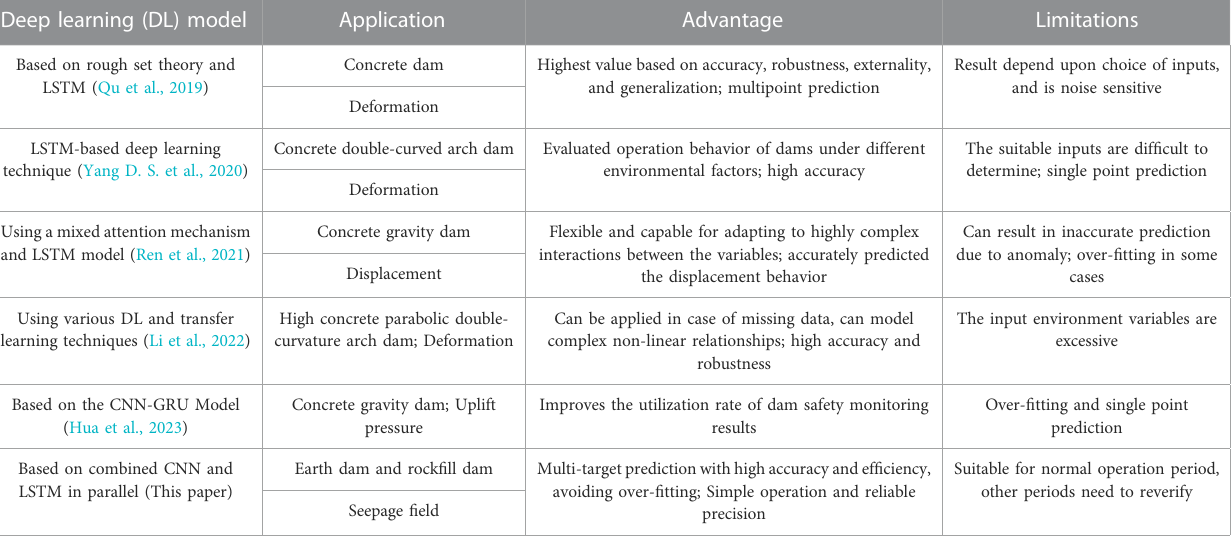
TABLE 1 A summary of deep learning in dam behavior